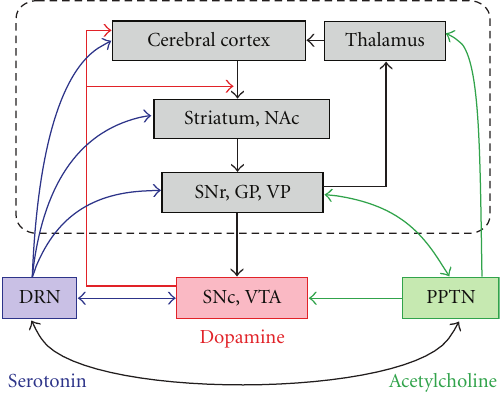
Figure 1: Simplified cortico-basal ganglia circuitry with dopamin- ergic, cholinergic, and serotonergic innervation. The main cortico- basal ganglia circuit is highlighted by the dashed rectangle and the gray-shaded boxes. Midbrain dopaminergic neurons receive inhibitory input from basal ganglia nuclei and project to the striatum and cerebral cortices. The PPTN and DRN interact with dopaminergic neurons and basal ganglia nuclei. Here, we consider only the major routes by which the basal ganglia and neuromodula- tors are interconnected. NAc: nucleus accumbens, SNr: substantia nigra pars reticulate, GP: globus pallidus, VP: ventral pallidum, SNc: substantia nigra pars compacta, VTA: ventral tegmental area, DRN: dorsal raphe nucleus, PPTN: pedunculopontine tegmental